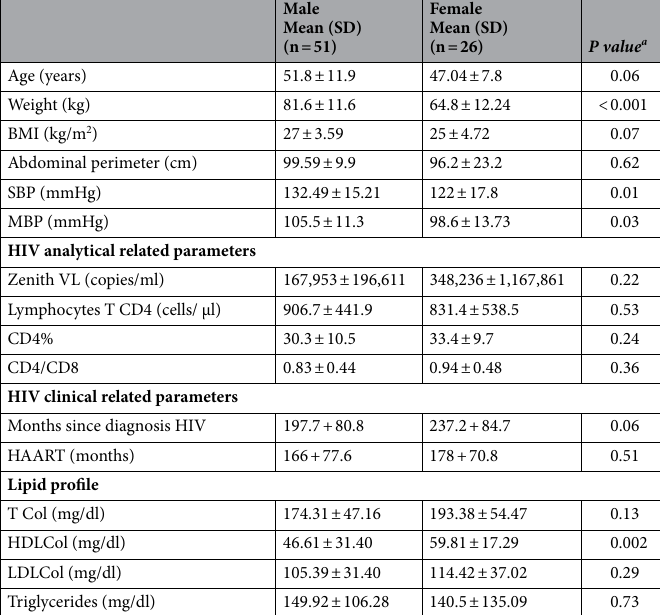
Table 1. Patient characteristics stratified by sex. SD standard deviation, VL viral load, HIV human immunodeficiency virus, HAART highly active antiretroviral therapy, T Col total cholesterol, HDLCol cholesterol bound to high density lipoproteins, LDLCol cholesterol bound to low density lipoproteins, SBP systolic blood pressure, MBP mean blood pressure. a Two-tailed one-way ANOVA